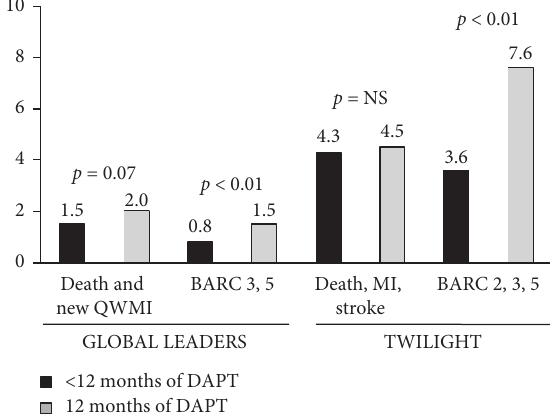
Figure 2: Bar graph showing the rate of major clinical events in clinical trials comparing 12-month dual antiplatelet strategy (DAPT) vs. a shorter strategy followed by ticagrelor